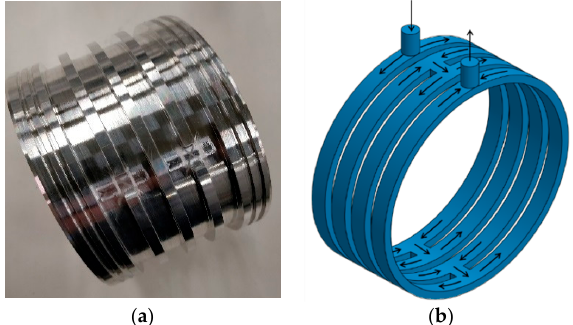
Figure 1. One of the two water jackets (WJ2) used in the study and the flow path of the coolant. It has two main channels with each channel having further two channels in series. ( a ) prototype; ( b ) coolant flowpath.